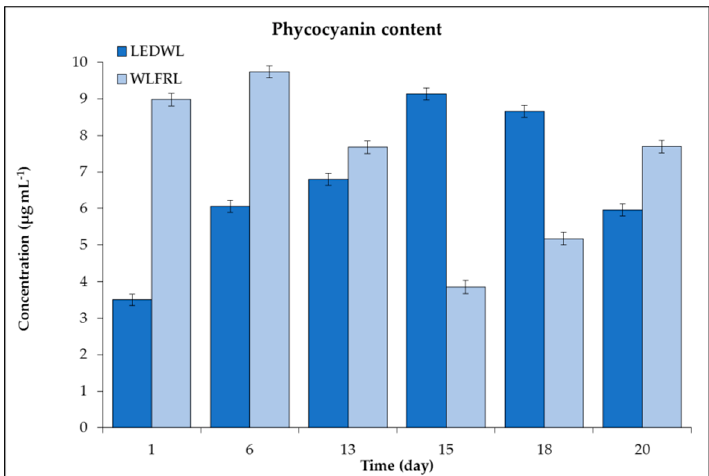
Figure 7. Phycocyanin concentration (µg mL − 1 ) of C. fritschii under LEDWL and WLFRL conditions.